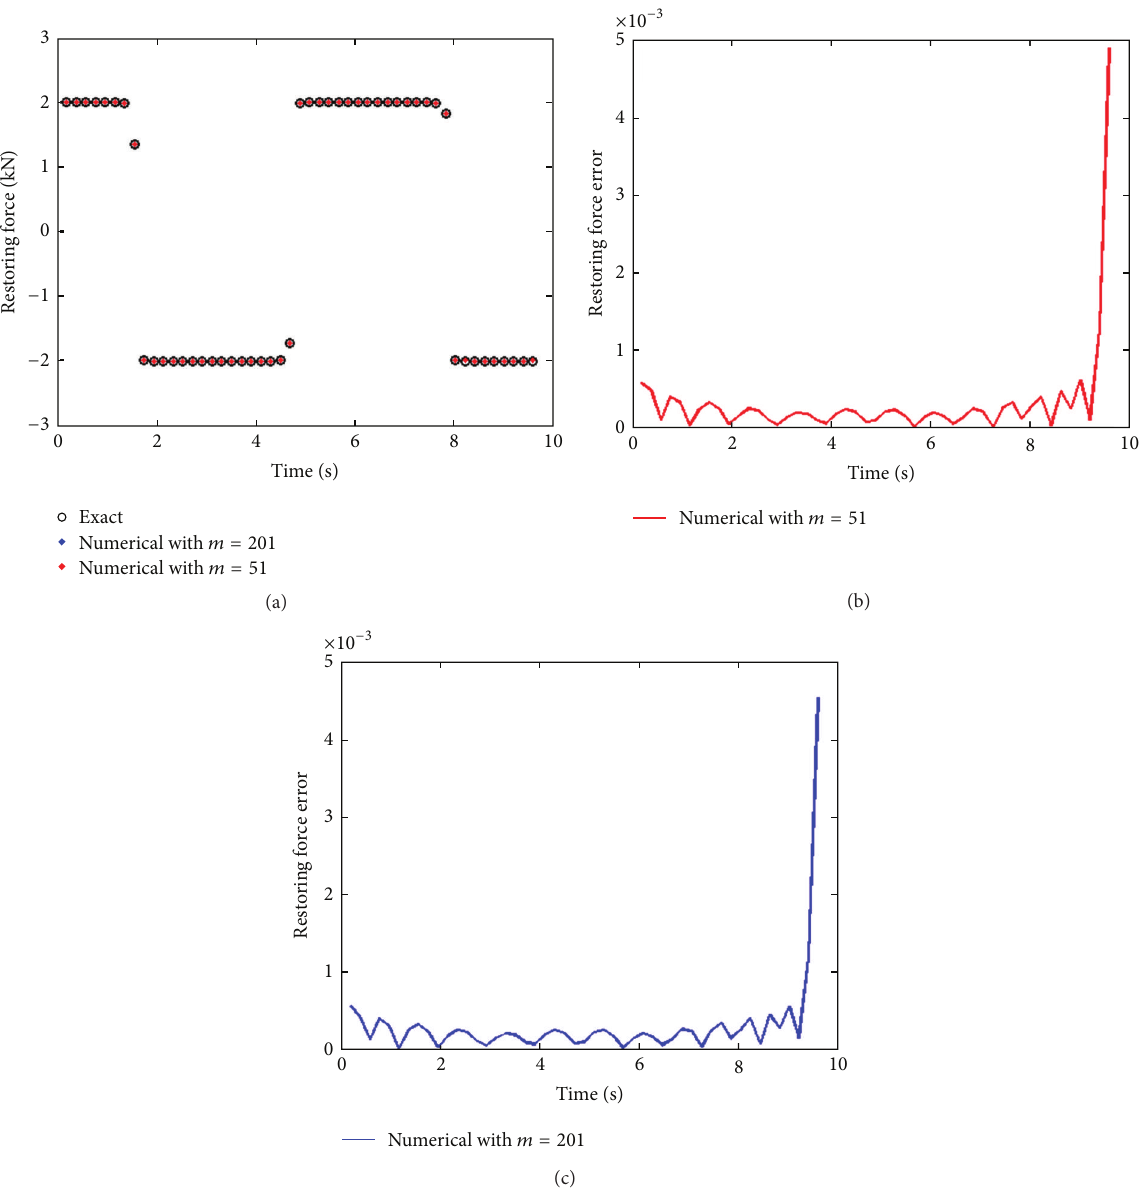
Figure 18: For Example 5, (a) comparing estimated and exact restoring forces, (b) displaying the estimation error of restoring force with 𝑚 = 51 , and (c) displaying the estimation error of restoring force with 𝑚 = 201 .